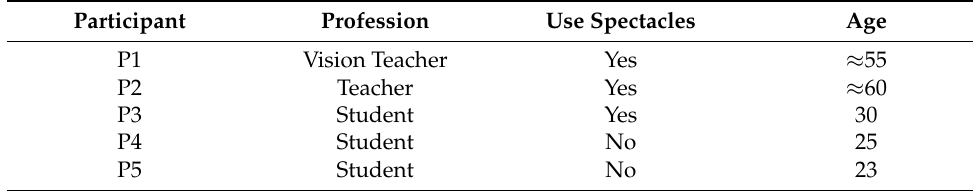
Table 4. The participants’